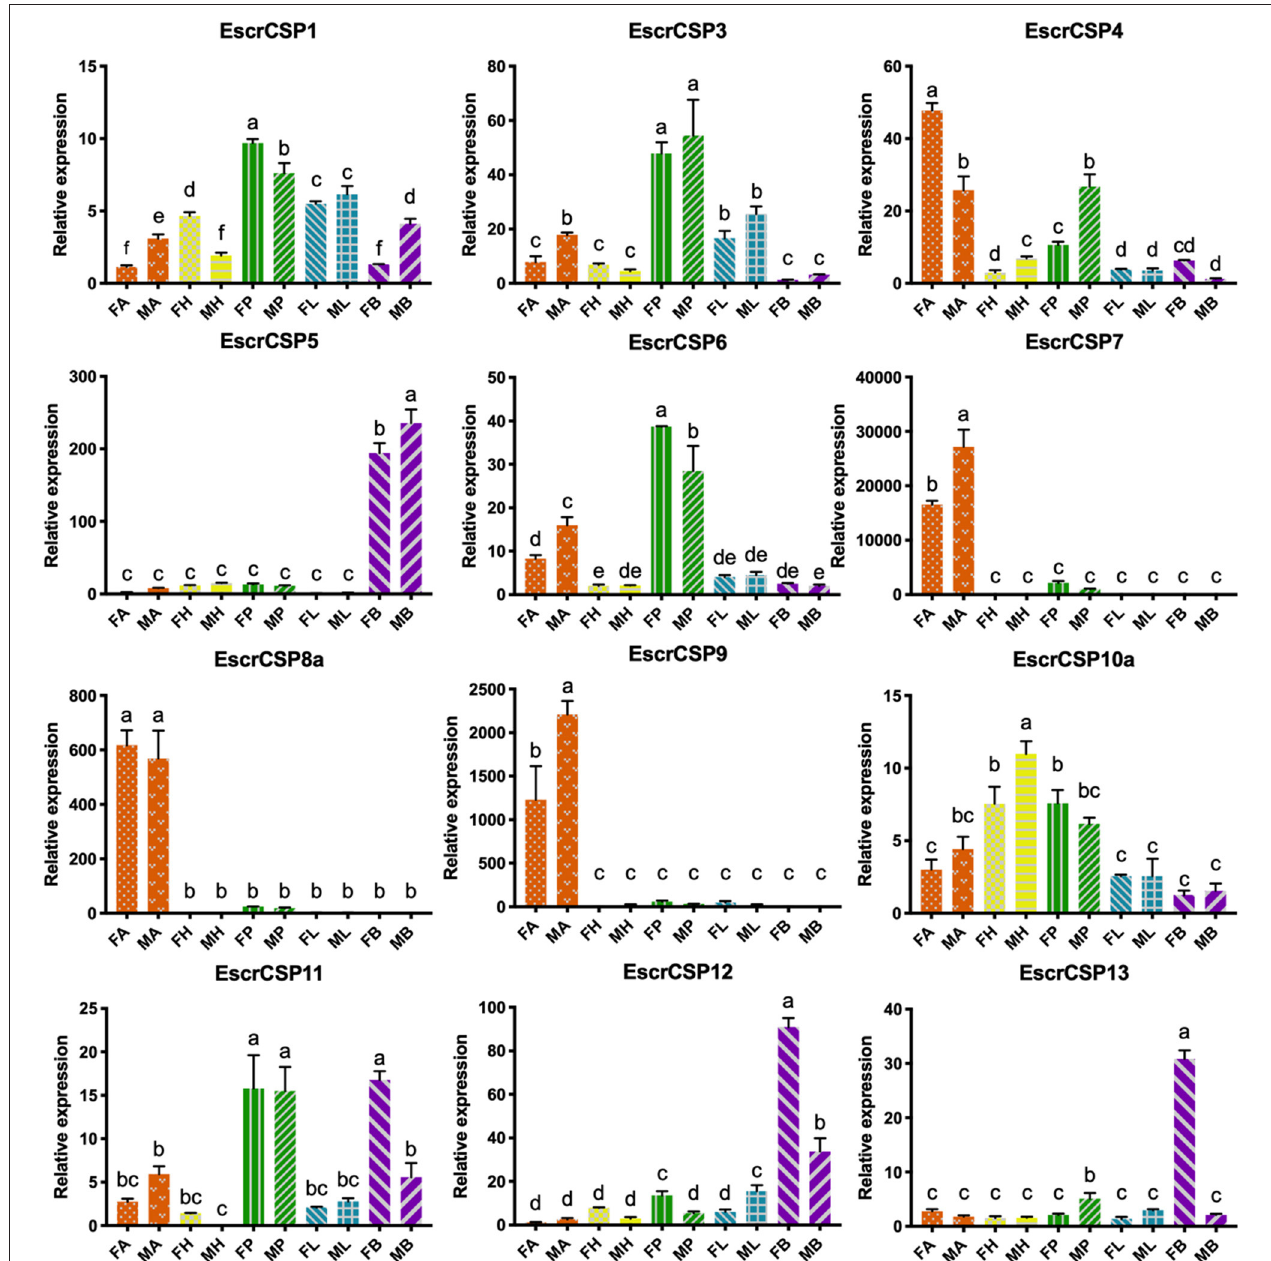
FIGURE 4 | Relative expression levels of EscrCSPs in different tissues of adults. FA, female antennae; MA, male antennae; FH, female head (without antennae); MH, male head (without antennae); FP, female proboscises; MP, male proboscises; FL, female legs; ML, male legs; FB, female abdomen; MB, male abdomen. The bar represents the standard error, and the different small letters (a–f) above each bar indicate significant differences ( P < 0.05).